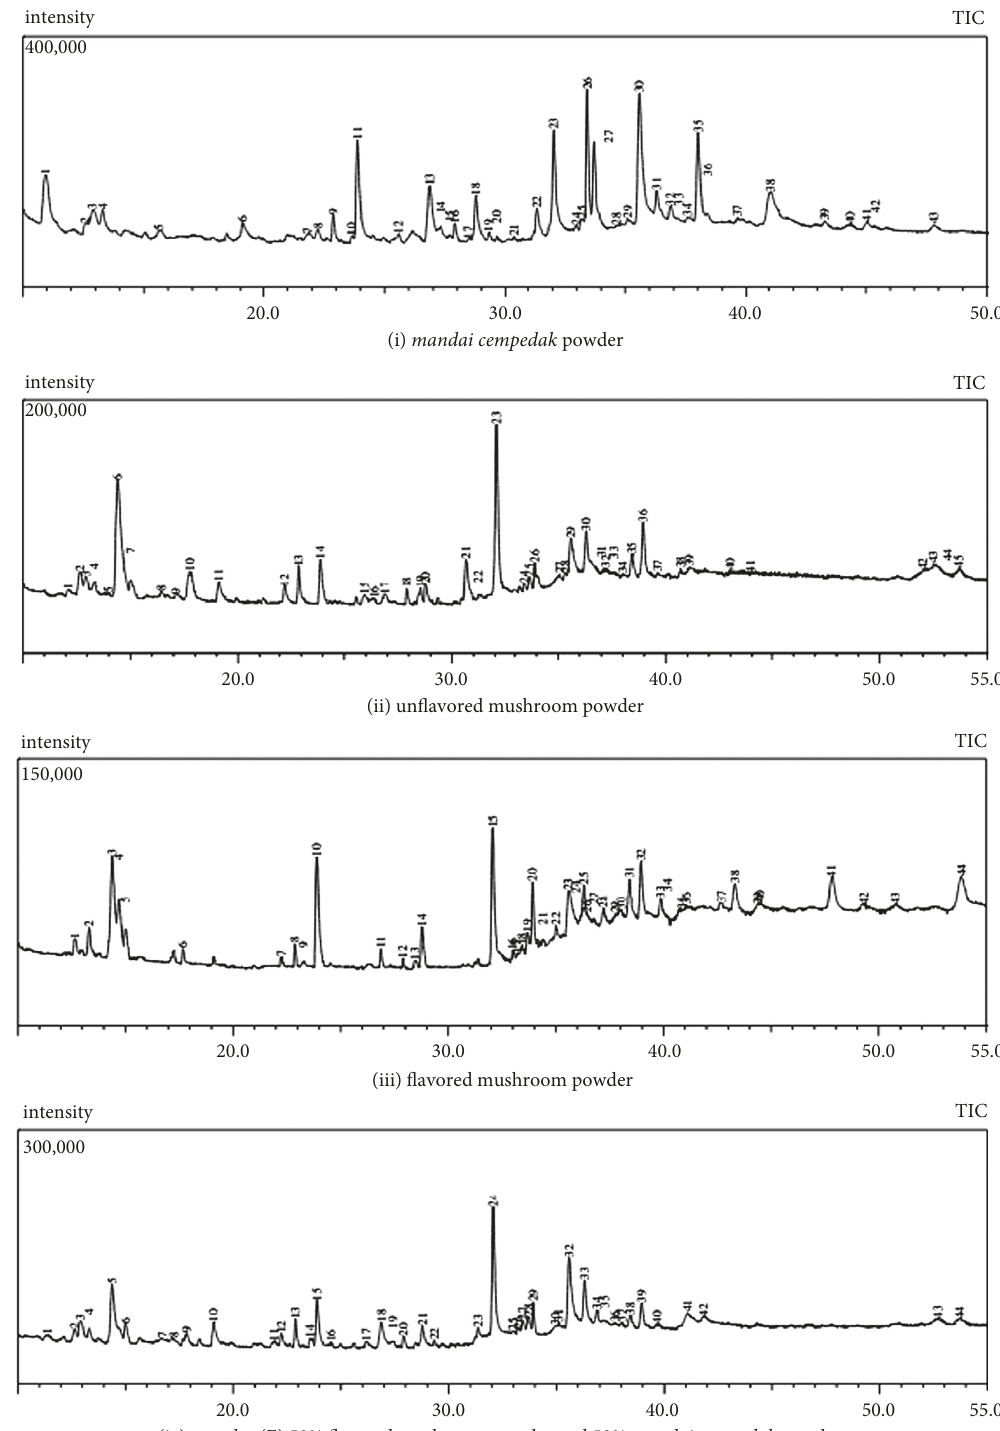
Figure 2: Chromatogram of